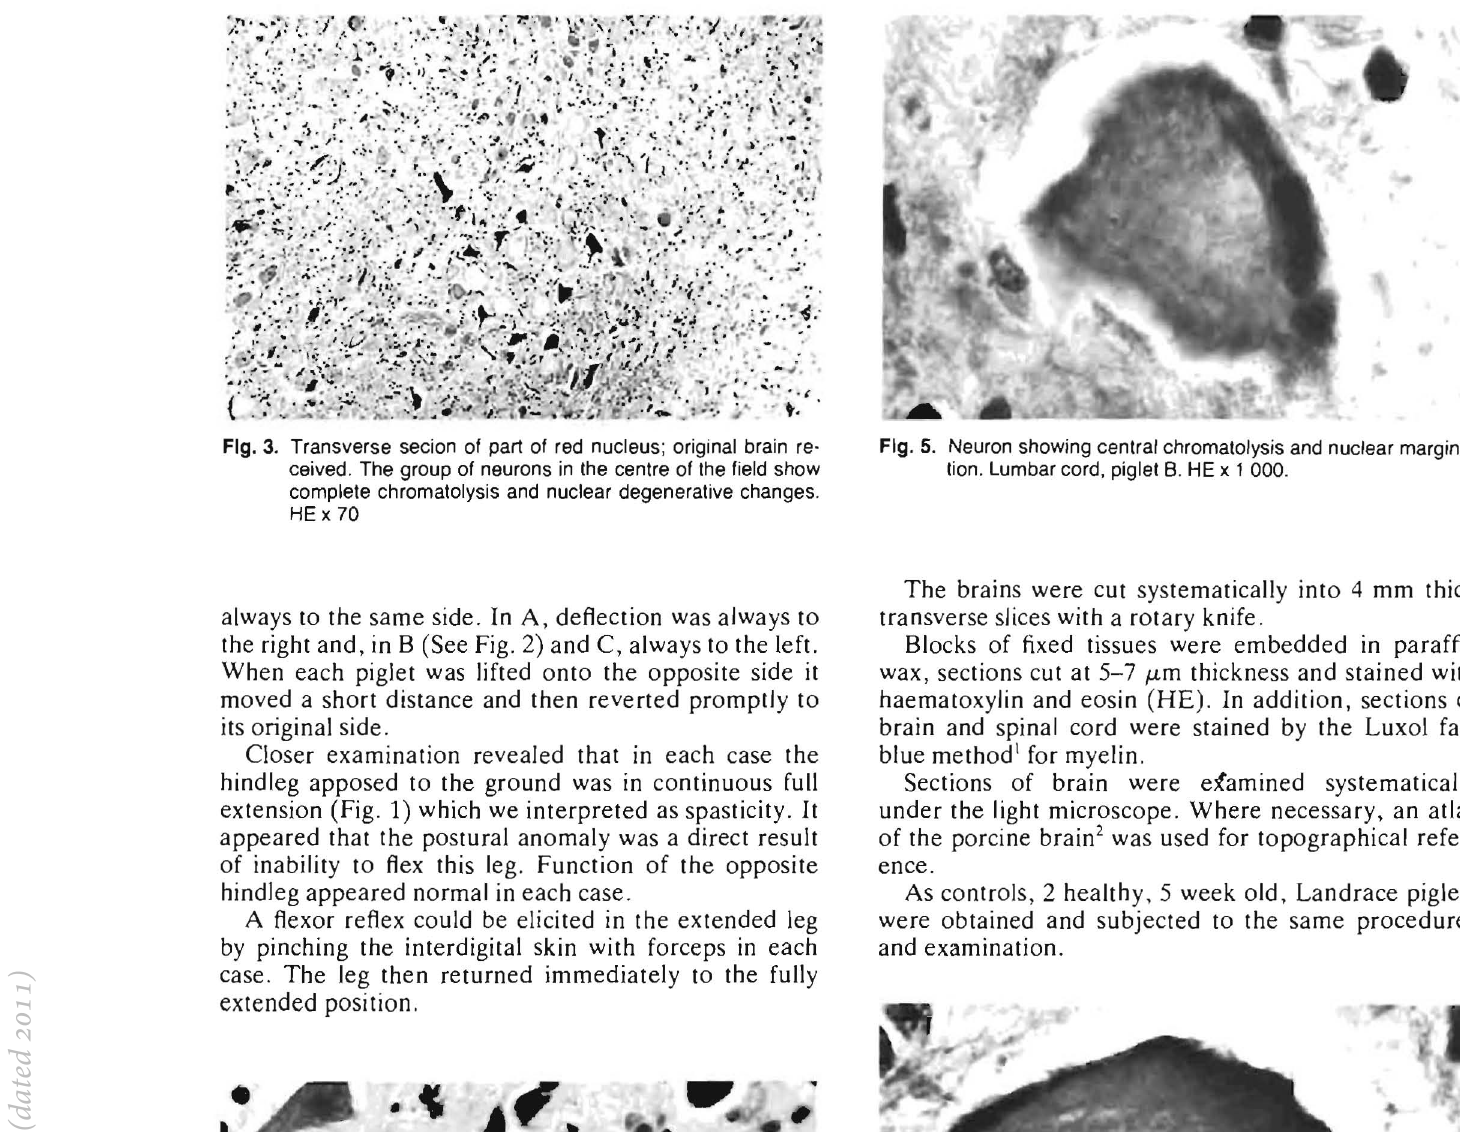
Fig. 4. Neuron in centre of field showing complete chromatolysis with nuclear margination and pyknosis. Lumbar cord. piglet